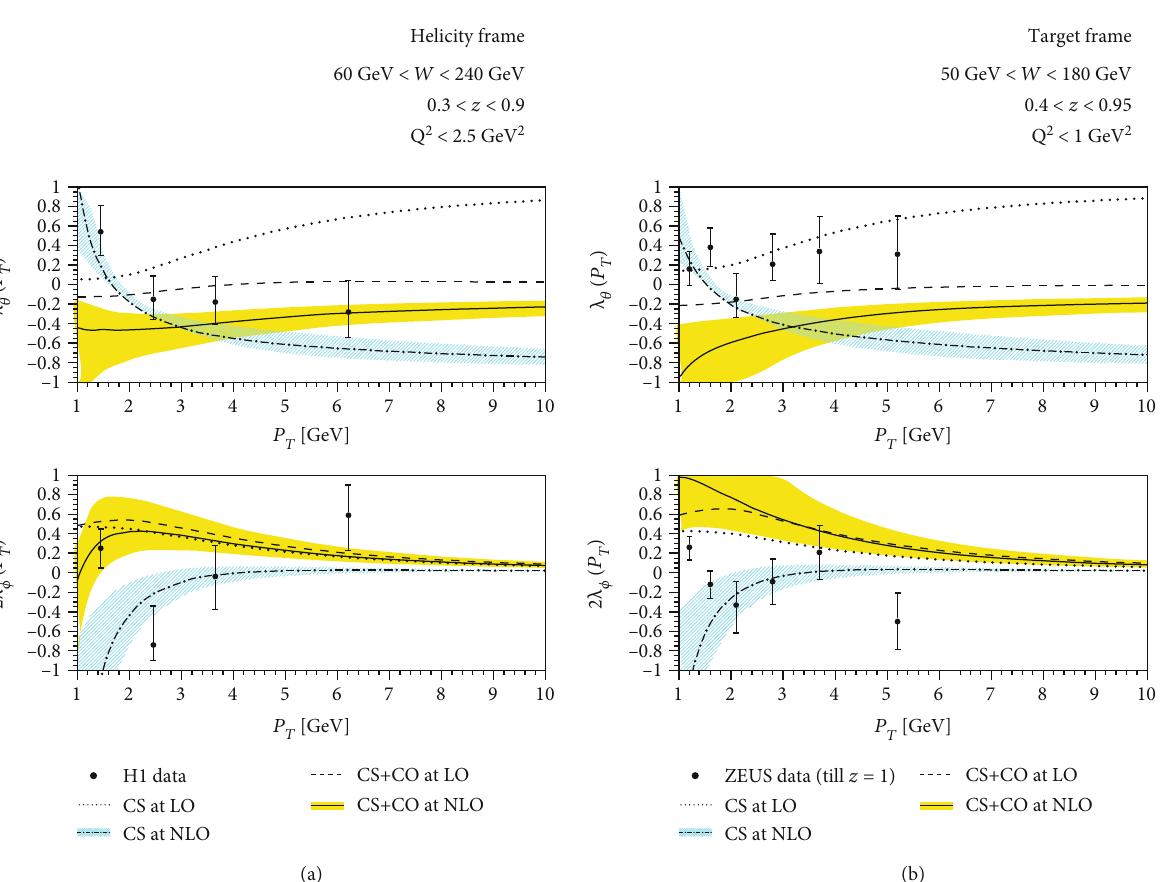
Figure 9: NLO NRQCD calculations for polarization observables as functions of p taken from Ref.